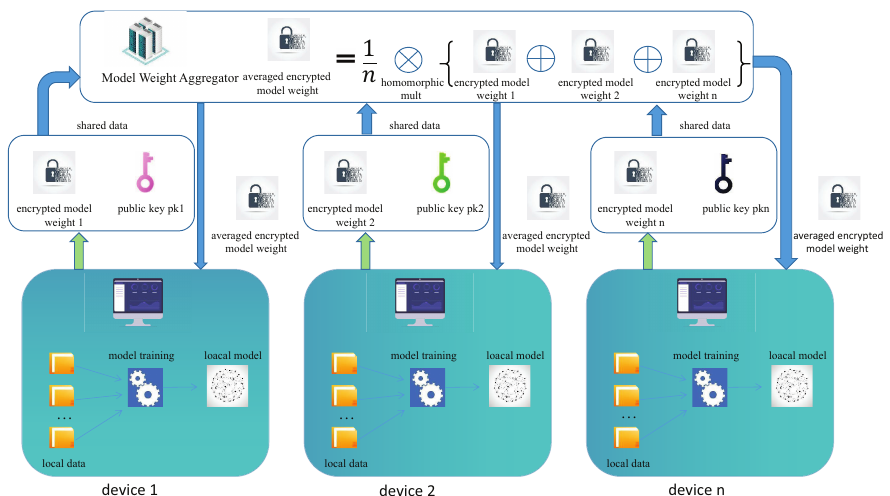
Figure 5. Typical application of MKFHE on Iot with federated